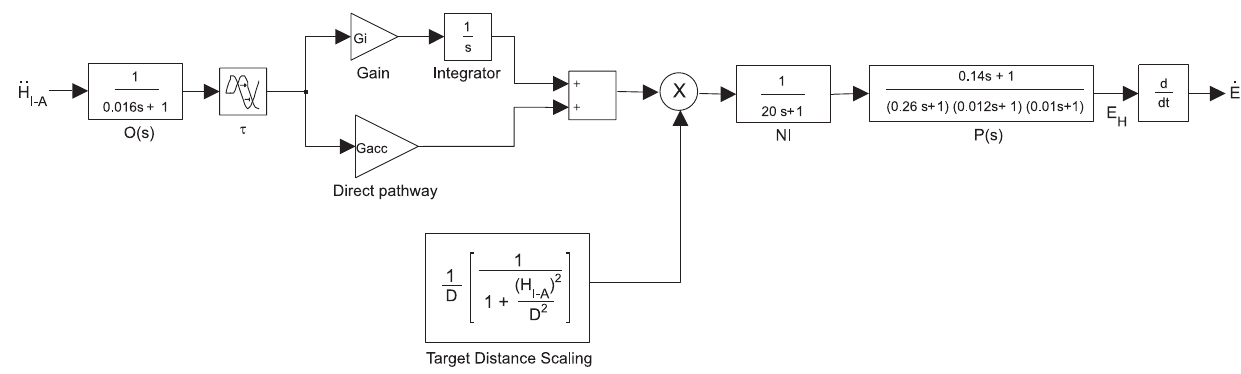
Figure 3. Simulink model of interaural TVOR. € HH I { A =linear head acceleration. E H =horizontal angular eye position. O(s)=otolith transfer function. G i =TVOR integrator gain. G acc =direct-pathway (acceleration) gain. t =time delay (response latency). NI=velocity-to-position neural integrator. P(s)=eye plant, H I 2 A =linear head position, D=perpendicular target distance.